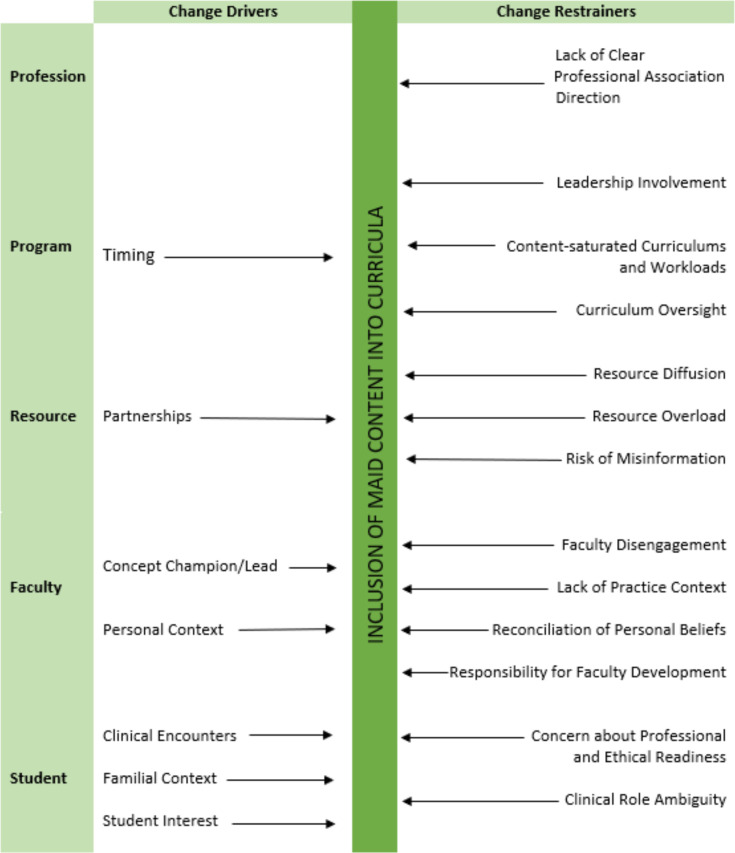
Graphical presentation of restrainers and drivers influencing MAID content inclusion into health sciences curriculum